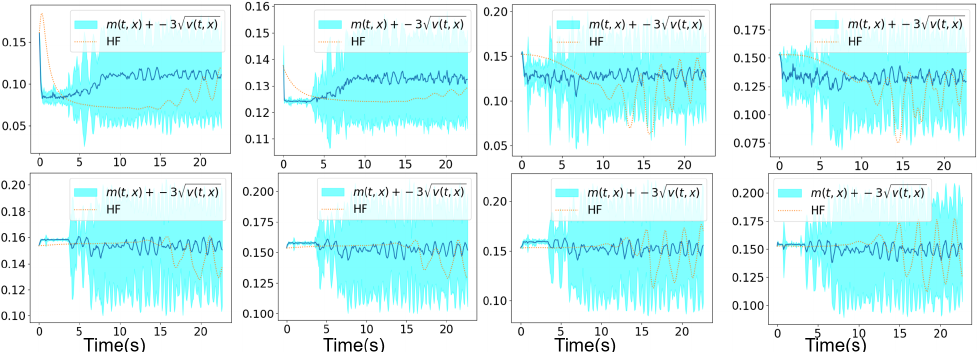
Figure 14. Mesh n°2: High-fidelity Yales2 horizontal velocity projected on the Cartesian mesh in brown and the horizontal component of the mean prediction of the Bayesian ROM in dark blue, at eight different spatial locations. The training data correspond to 15 s simulation time starting from 0 s. An extrapolation is performed from 15 s until 22.64 s. The clear blue zones are the ones contained in three standard deviations around the mean prediction of the ROM denoted m ( t , x ) . The mean prediction is obtained using an aggregation of five samples of the Navier–Stokes solution by the Bayesian nonlinear